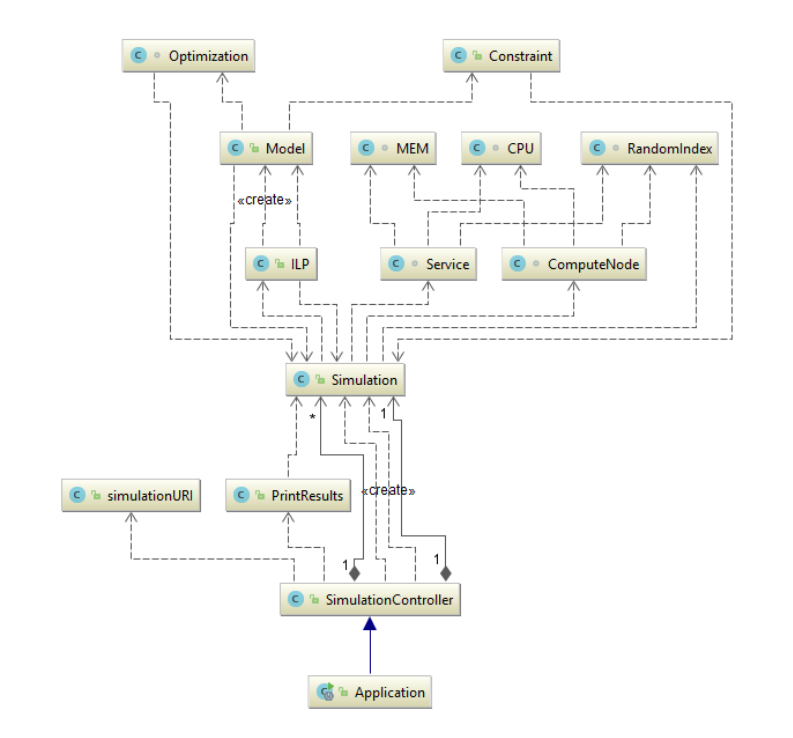
Figure 7. The class diagram of the ILP REST API generated with IntelliJ